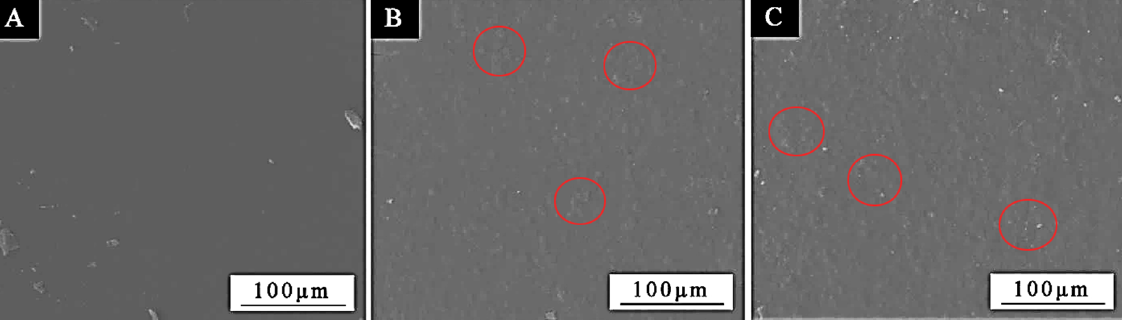
Figure 11. Morphology of the coatings with the addition of different microcapsule loadings on metal surface: ( A ) 0%, ( B ) 10.0%, ( C ) 15.0%.